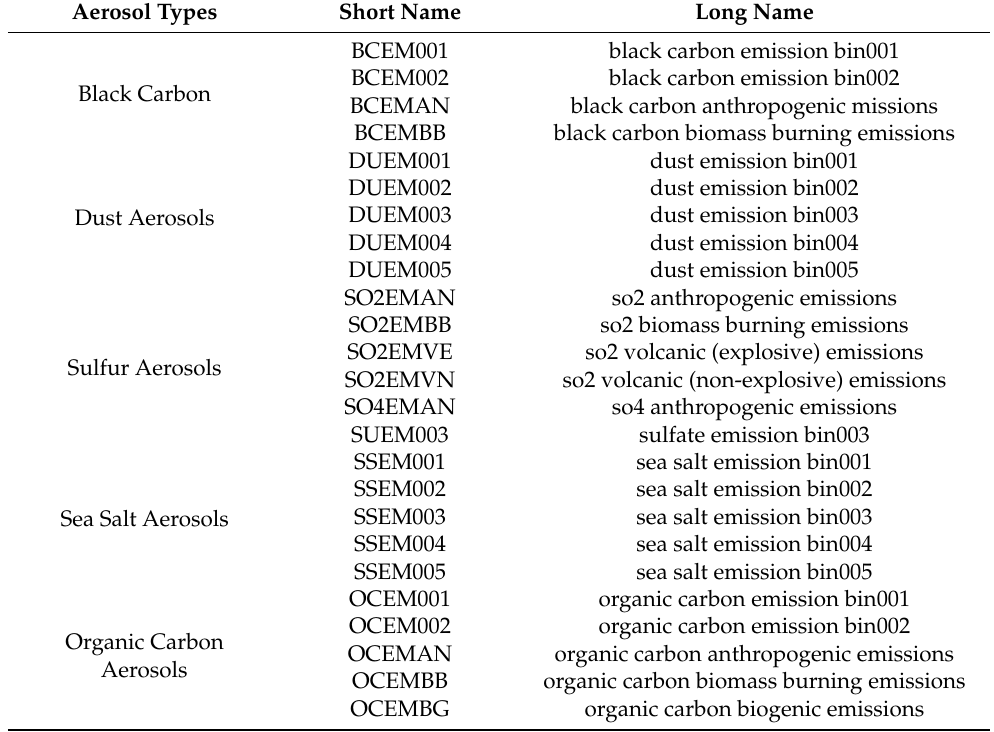
Table 2. Information about aerosol emission